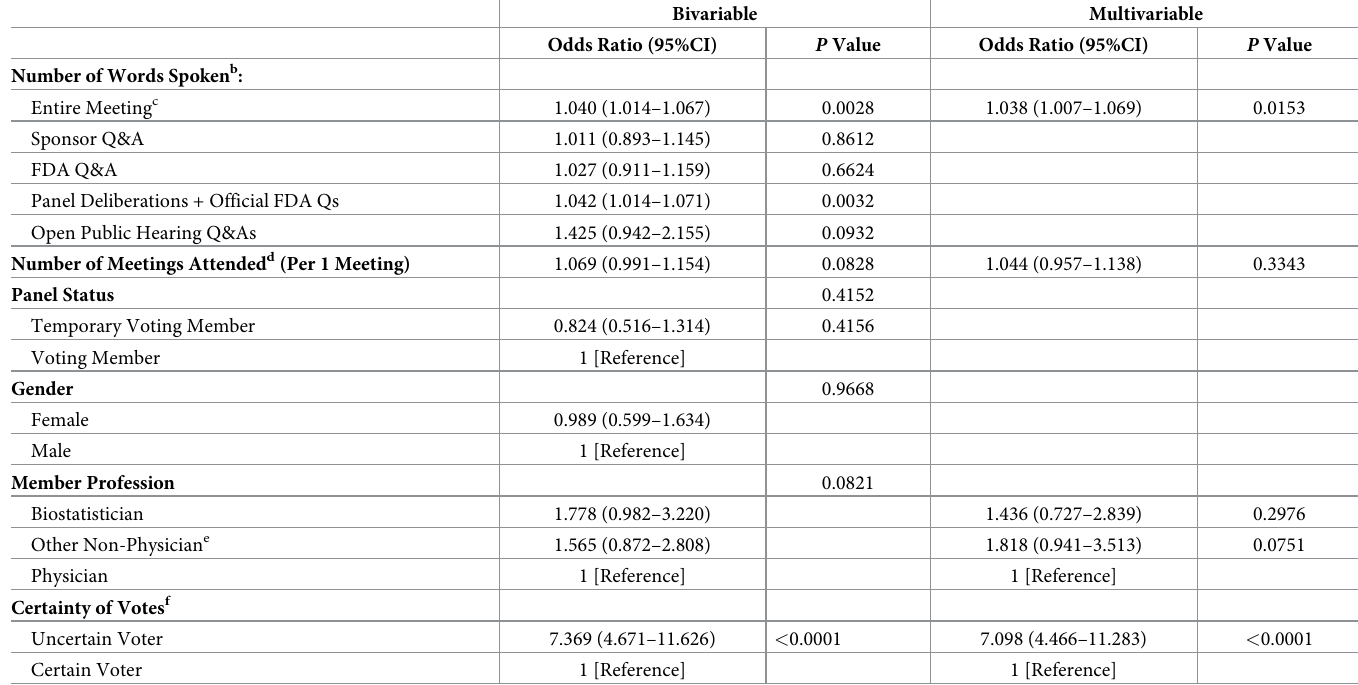
Table 4. Univariable and multivariable analysis of characteristics associated with voters not voting with the majority a